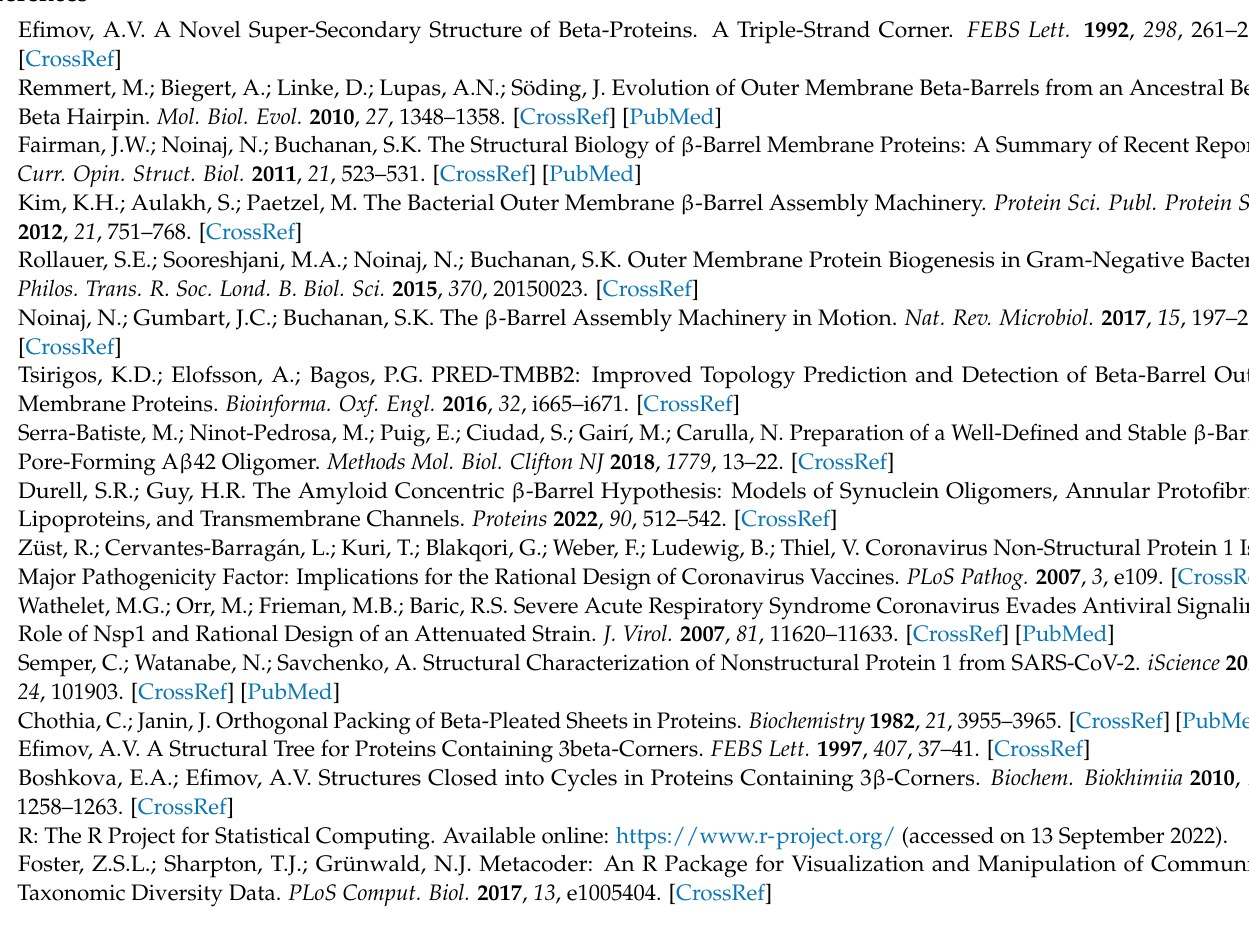
Table S2: The biological role of the studied